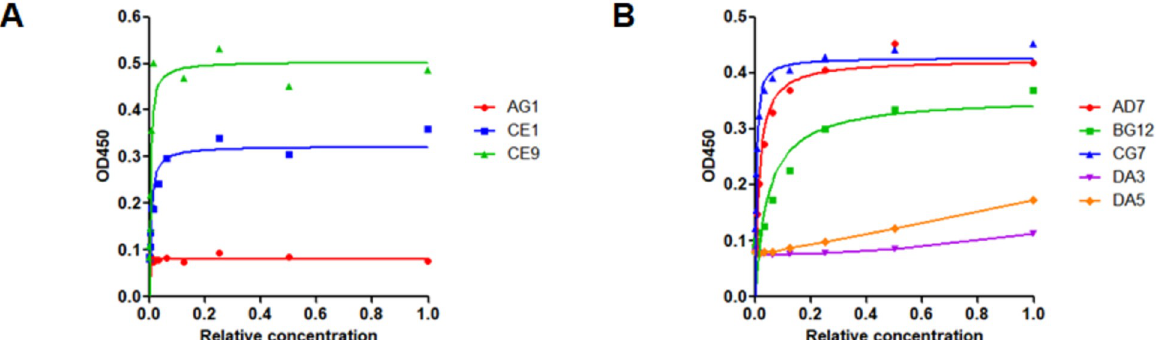
Fig 7. Selection of Fabs that bind the AP2 complex. For the quantitative ELISAs serial dilutions of supernatant from independent clones were added to wells coated with biotinylated AP2 core A . and AP2 muCTD B . The non-diluted supernatant was defined as having a relative Fab concentration of 1. The Fab bound to the wells was detected with anti-myc antibody conjugated to peroxidase. Fabs CE1 and CE9 for AP2 core and Fabs AD7, BG12 and CG7 for AP2 muCTD displayed dose-dependent saturating signals.